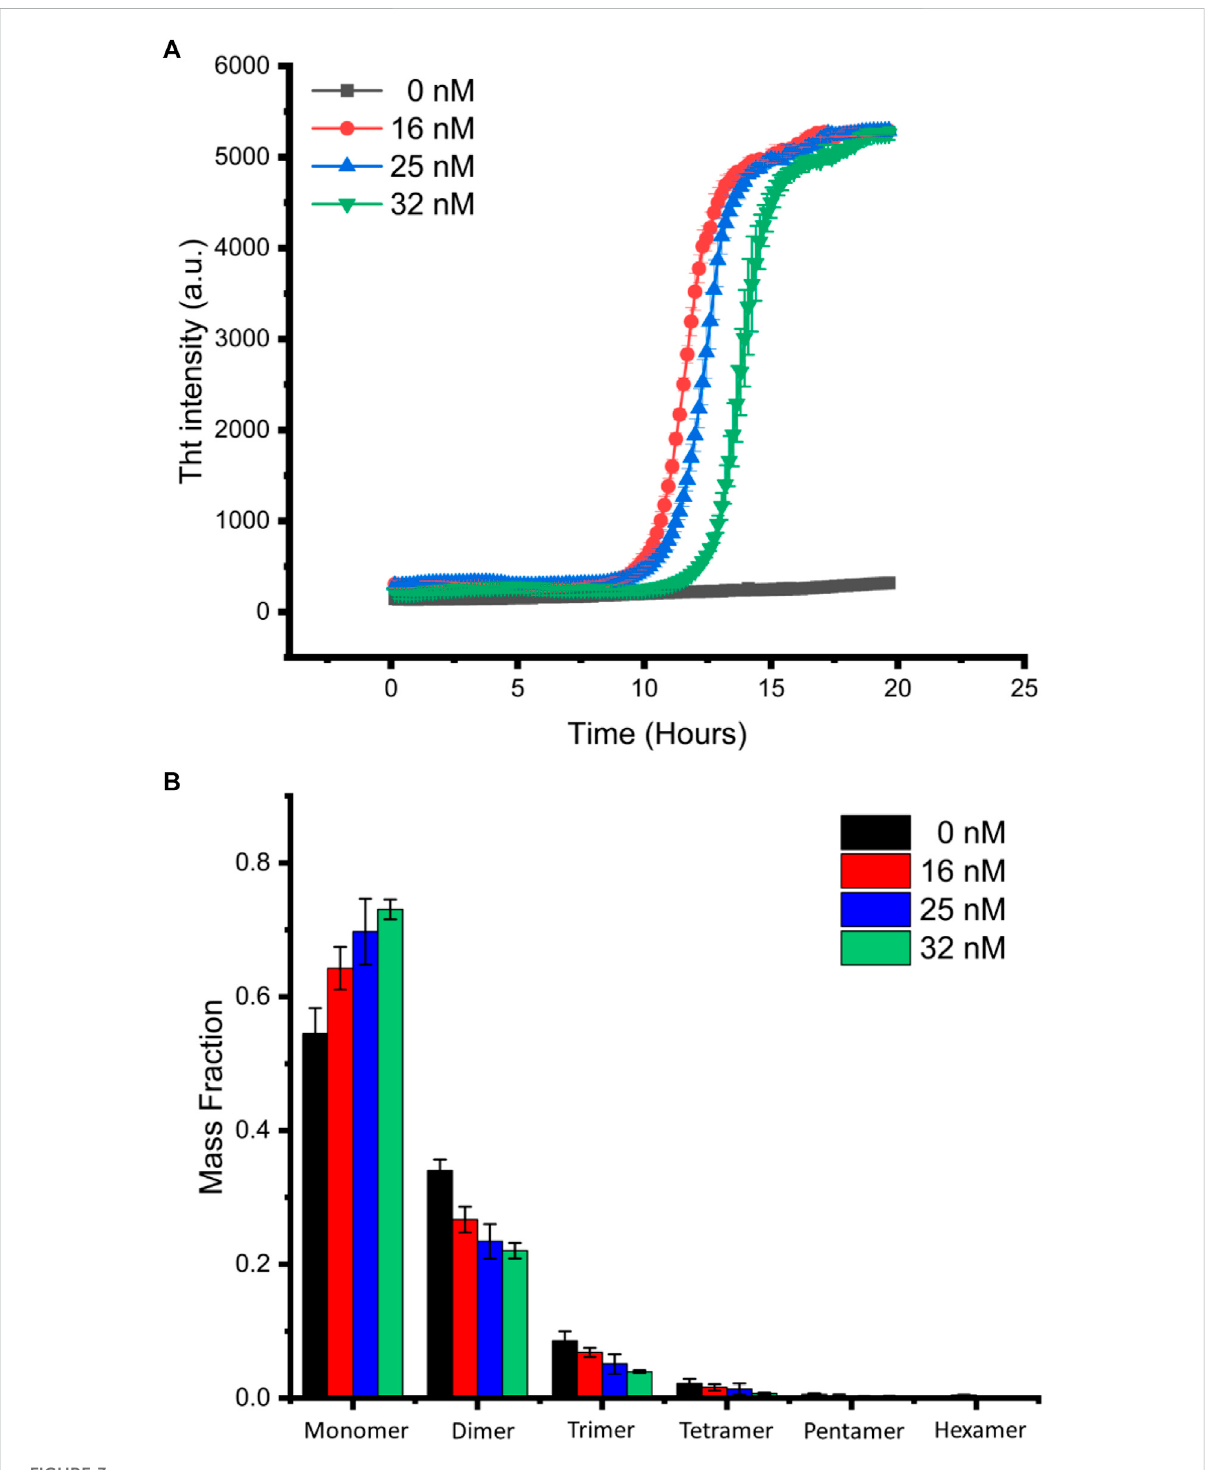
FIGURE 3 Single-molecule analysis of α -synuclein oligomer distribution. (A) α -Synuclein aggregation in the presence of different concentrations of gold nanoparticles was monitored by ThT assay. The curves shown are the average of the triplicates. (B) Mass fraction of α -synuclein species in aggregation solution at 12-h